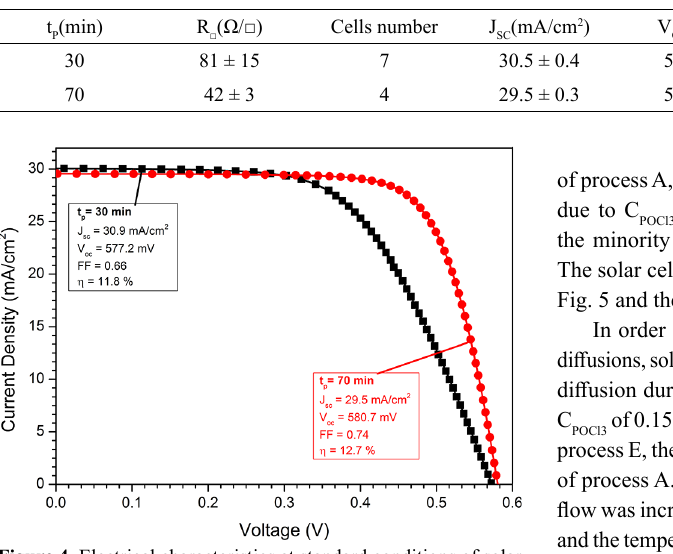
) during the entrance of the wafers GAS